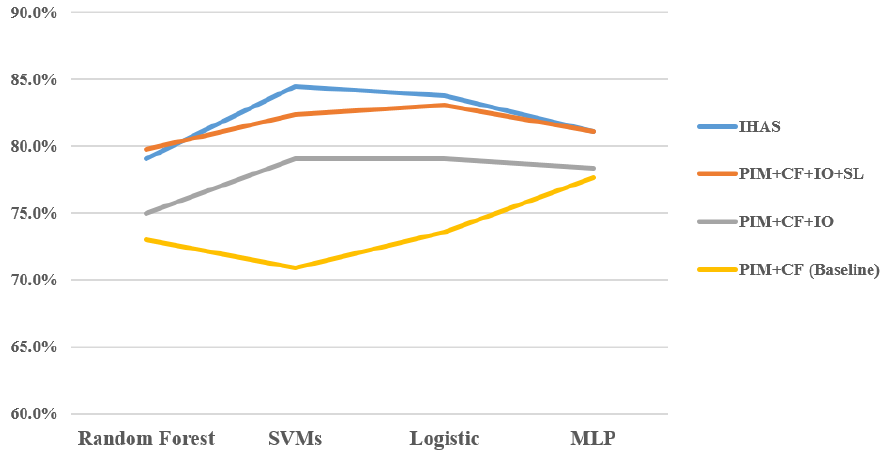
Figure 4. The Accuracy of IHAS.